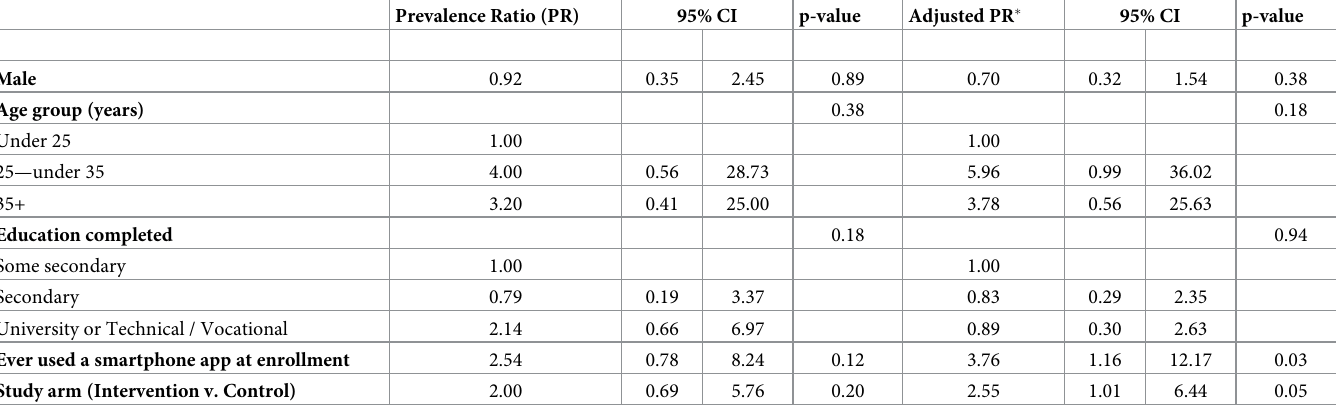
Table 2. Demographic characteristics associated with being in the top response rate